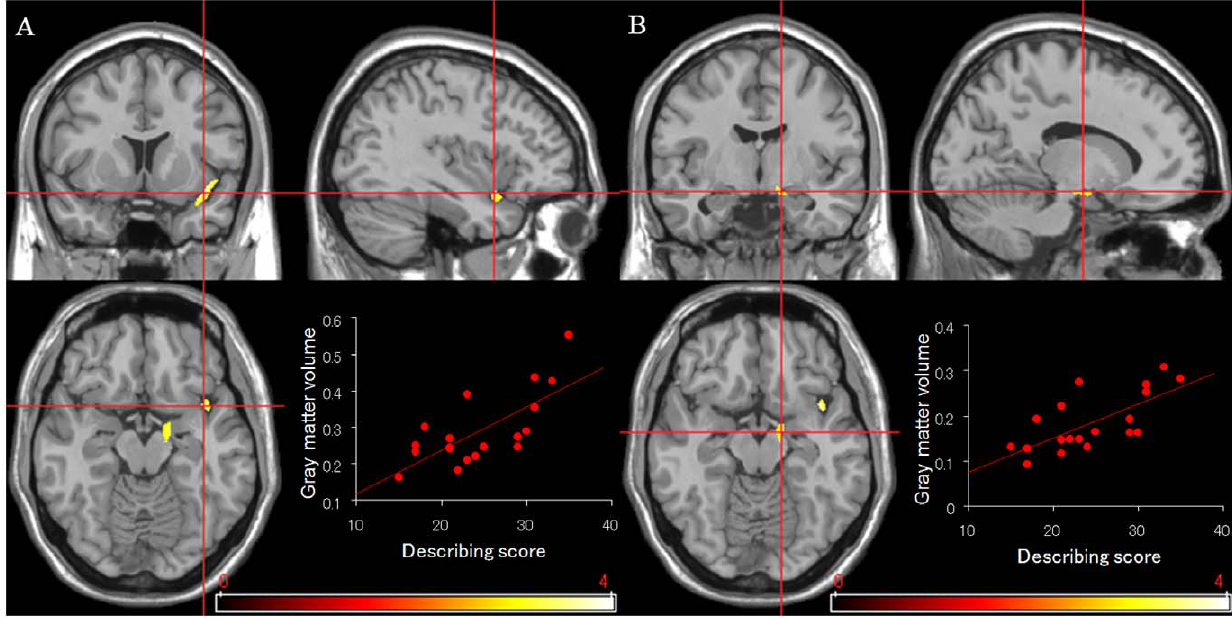
Figure 1. Correlations of the score of the describing facet in mindfulness tendency and gray matter volume. Results of correlation analyses showing the positive correlations between the score of the describing facet and the gray matter volume in the right anterior insular cortex (A), and in the right parahippocampal gyrus/amygdala (B). An uncorrected p value of 0.005 was used as the threshold.